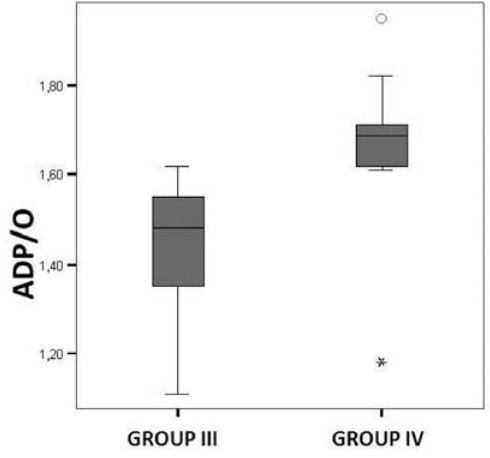
Figure 3 - ADP/O ratio (ratio of ADP added to oxygen consumed) in ischemic livers of steatotic control group III and steatotic SNAC group IV; p=0.01.